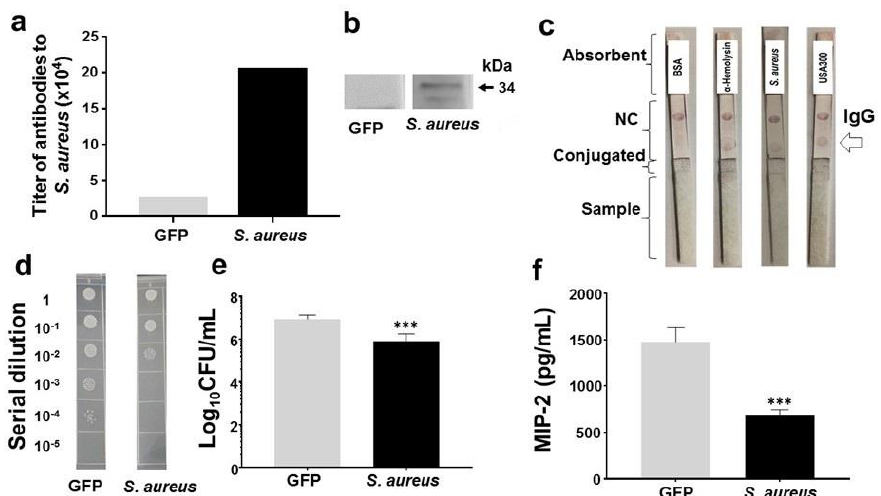
Figure 4. The production of antibodies to α-hemolysin and USA300 by vaccination of commensal S. aureus and protection against USA300. ICR mice subcutaneously vaccinated with lysates of commensal S. aureus (but not those vaccinate with recombinant GFP) produced detectable antibodies (IgG) to S. aureus ( a ) or α-hemolysin ( b ) in quantitative OD 570-450 measurement and Western blot analysis, respectively; ( c ) the production of antibodies to S. aureus or α-hemolysin and their cross-reactivity with USA300 was detected in test strips with NC membranes spotted with BSA, α-hemolysin, or lysates of S. aureus or USA300 (lower position) and rabbit anti-mouse IgG secondary antibody (upper position); ( d ) a 1 cm wound was made on the dorsal skin of vaccinated mice, followed by applying USA300 for 3 days. Bacterial CFUs in the skin wounds were enumerated by plating serial dilutions of the homogenate on a plate. The number (log 10 CFU/mL) of USA300 ( e ) and the level of pro-inflammatory MIP-2 cytokine ( f ) were quantified. *** p < 0.001 (two-tailed t -tests). Data are the mean ± SD of three separate experiments.